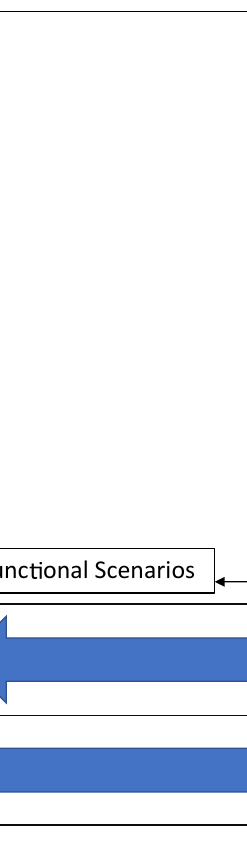
Figure 1. Terminology of the three scenario types (after Reference